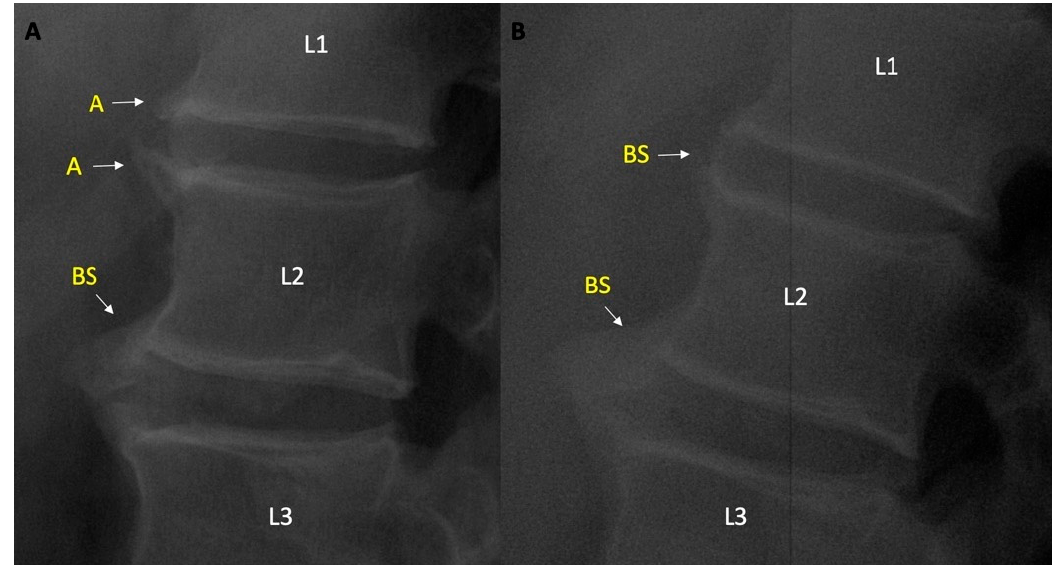
Figure 2. ( A ) Ambiguous lesions on L1 lower and L2 upper vertebral units and BS between L2 lower nad L3 upper vertebral units. ( B ) Turning of Ambiguous lesions to bridging syndesmophytes during follow up. A—ambiguous lesion; BS—bridging syndesmophyte. L1/L2/L3 indicate 1st, 2nd, 3rd lumbar vertebrae respectively.